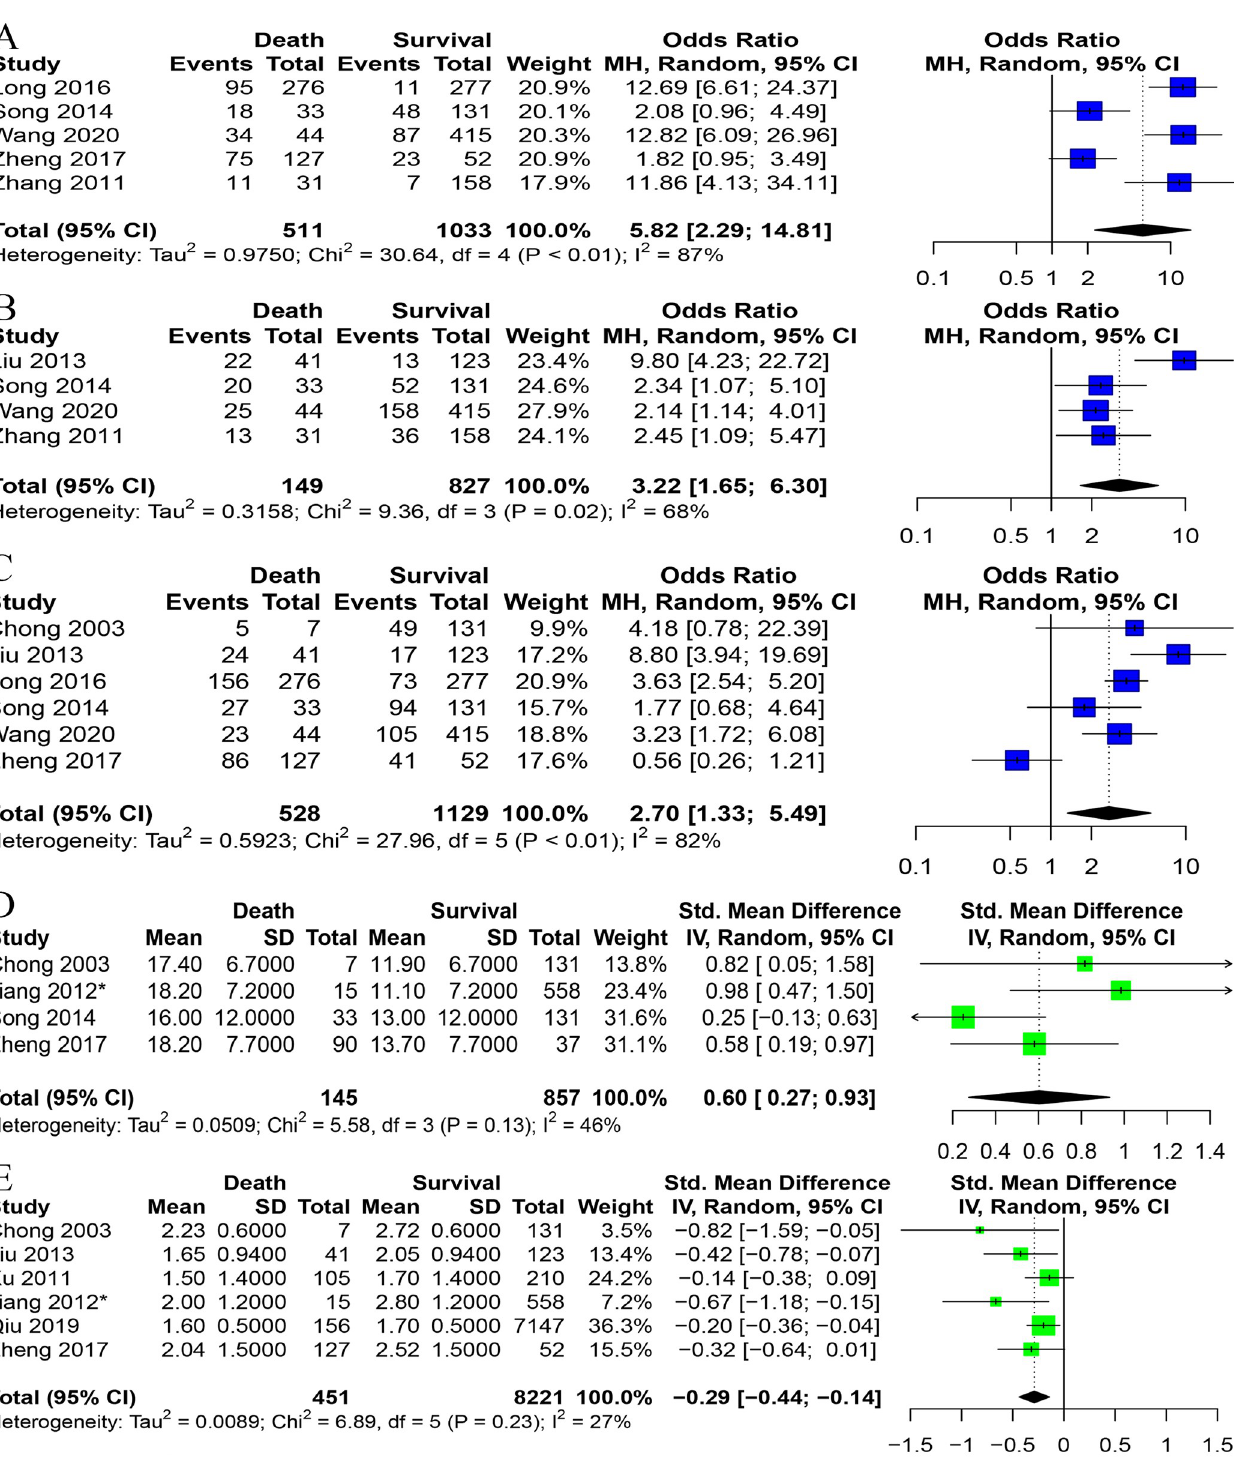
Fig 4. Forest plots on a panel of risk factors. A Cyanosis, B Fast heart rate, C Vomiting, D WBC count, E Age. � Data is converted from the original data.